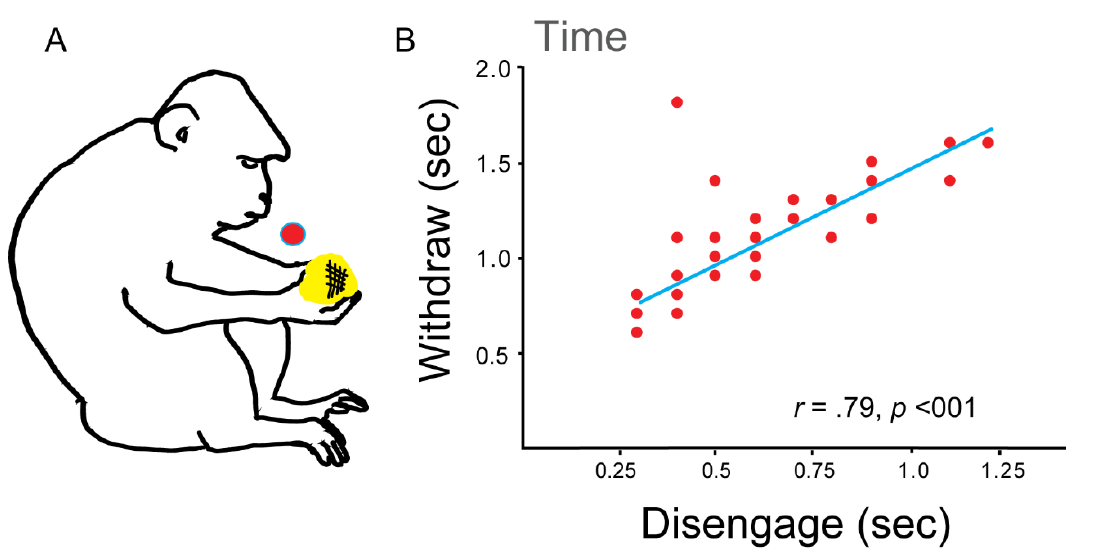
Head-Disengage for Inhand-Withdraw by a Macaque Named “Serenade”